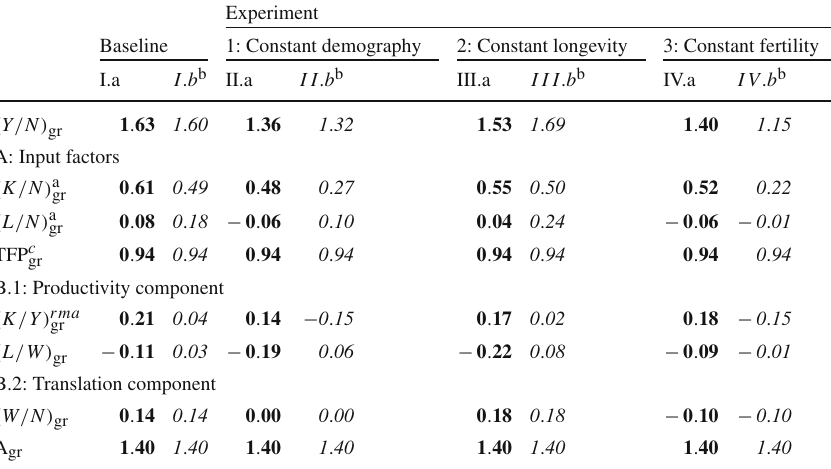
Table3 Sourceofper-capitaoutputgrowthfrom1850to2000bydemographiccomponent(annualaverage logarithmic rates in percent) Source Authors’ calculations based on the OLG